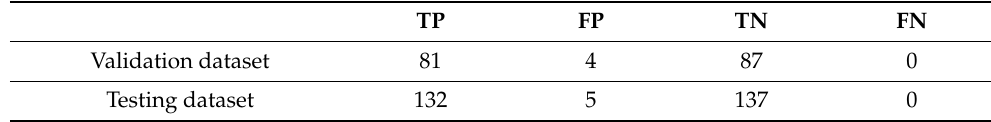
Table 2. Performance of ResNet model on our dataset.